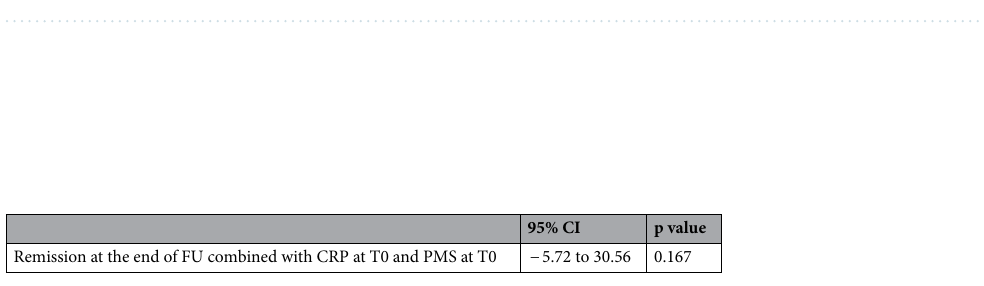
95% CI p value Remission at the end of FU combined with CRP at T0 and PMS at T0 Table 4. Multivariable logistic regression for CRP and PMS at T0 in the IFX group (n = 15). Type: independent values (CRP and PMS at T0). CI confidence interval.